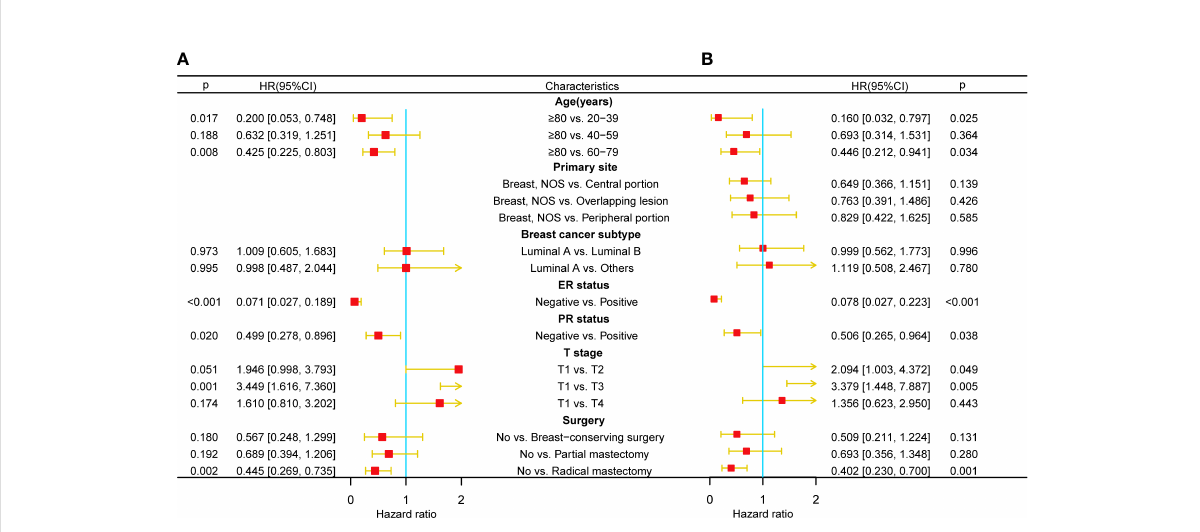
FIGURE 3 Multivariate COX regression forest plots for OS and CSS in MBCBM patients. (A) The forest plot for OS. (B) The forest plot for